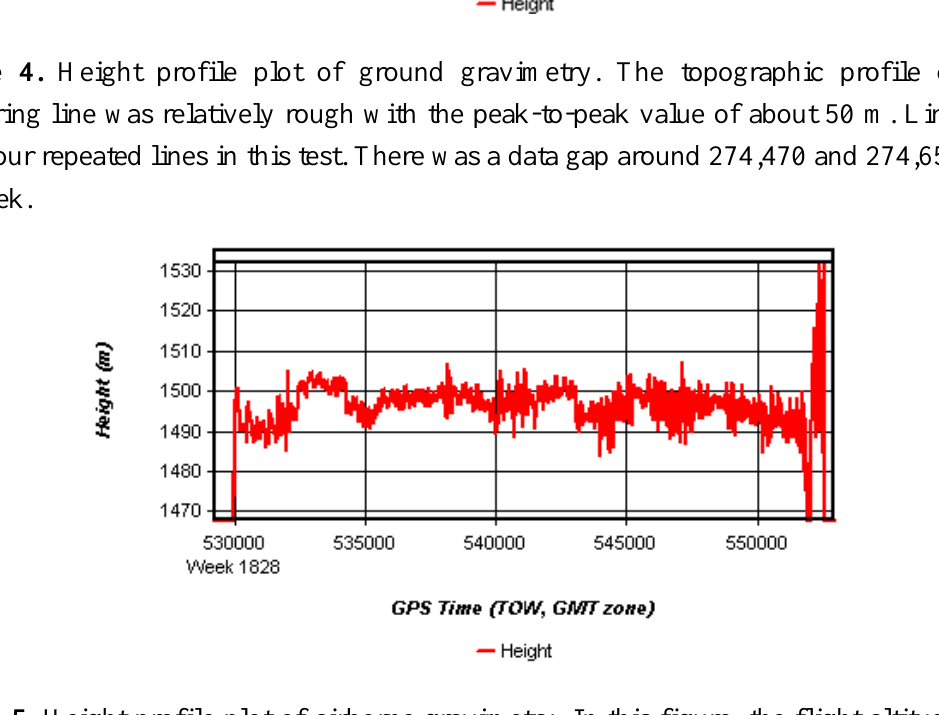
Figure 5. Height profile plot of airborne gravimetry. In this figure, the flight altitude was about 1500 m above the sea-level, meanwhile, 400 m above the ground. The variation around setting altitude was about ±8